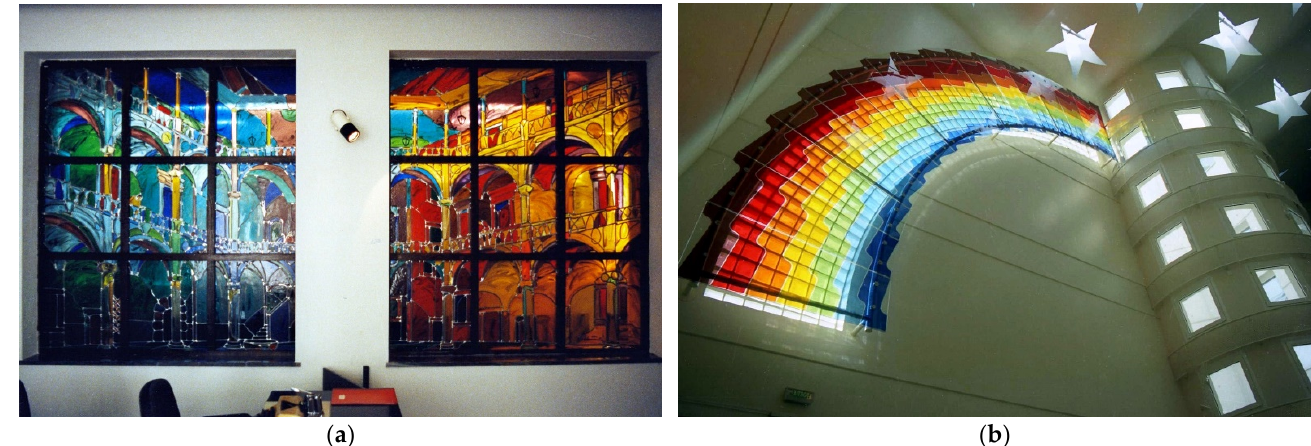
Figure 1. ( a ) Diptych stained glass by Tomasz Urbanowicz depicting the courtyard of the Castle of the Silesian Piasts in Brzeg, Poland, 1993; ( b ) pigmented resin-laminated rainbow by Tomasz Urbanowicz at College George Brassens in Paris, France, 1993 (Tomasz Urbanowicz).